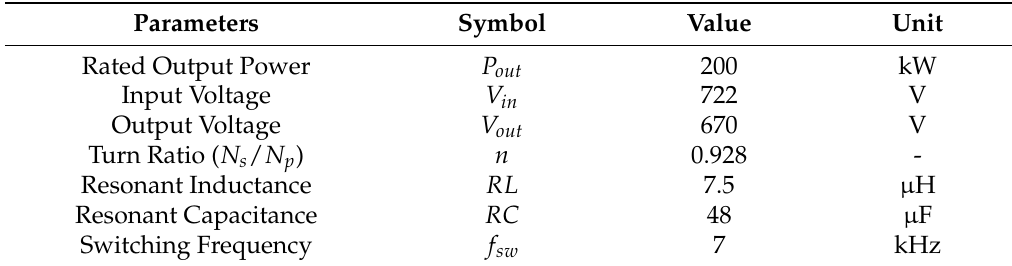
Table 2. LLC resonant converter design